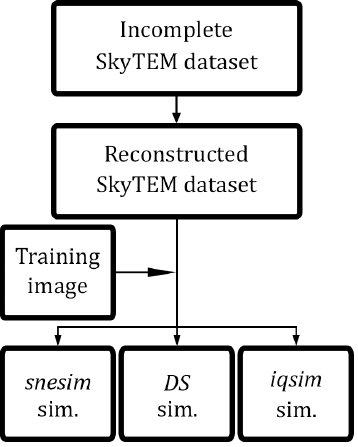
Figure 4. The hydrostratigraphic–resistivity relation shown as a se- ries of histograms. (a) shows the histograms created by categorizing the DS reconstructed resistivity grid according to the simplified hy- drostratigraphic model created by Høyer et al. (2015a), (b) shows the histograms created by categorizing a resistivity grid which has been reconstructed using kriging, (c) shows the histograms resulting from the resistivity atlas approach presented by Barfod et al. (2016), and (d) shows the resistivity atlas histograms that have been repro- duced based on the summary statistics from (c) to create a set of lognormal